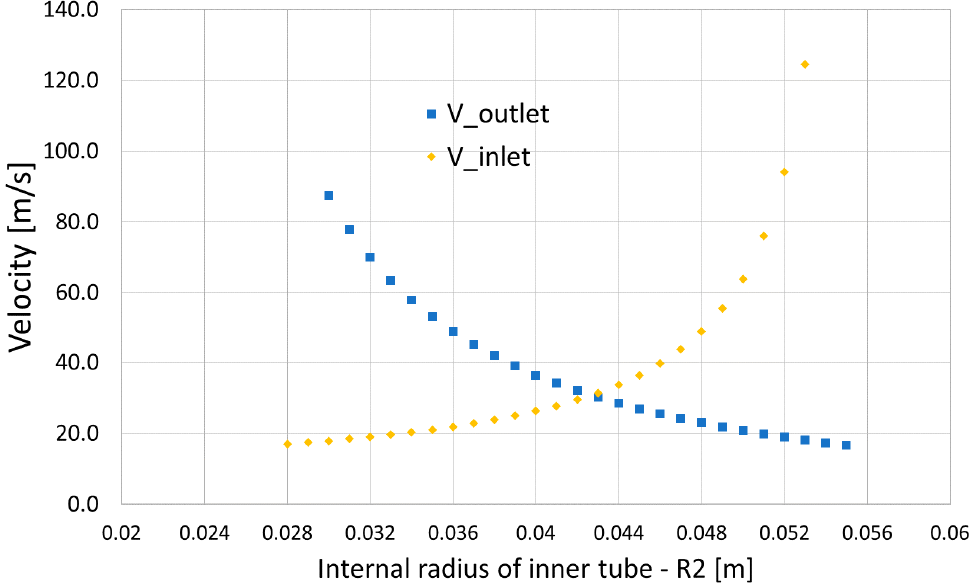
Figure 8. Value of the inlet and outlet velocities vs. R 2 radius values.